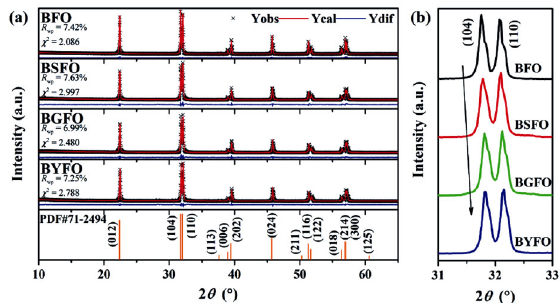
Fig. 1 (a) Rietveld-refined XRD patterns and (b) the partial enlarged XRD peaks of BFO, BSFO, BGFO, and BYFO